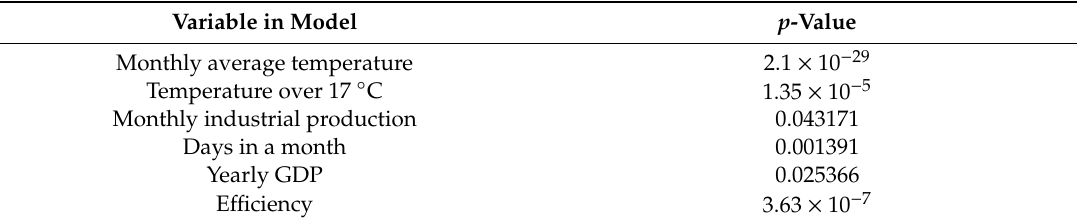
Table 2. p -value for the selected variables in the